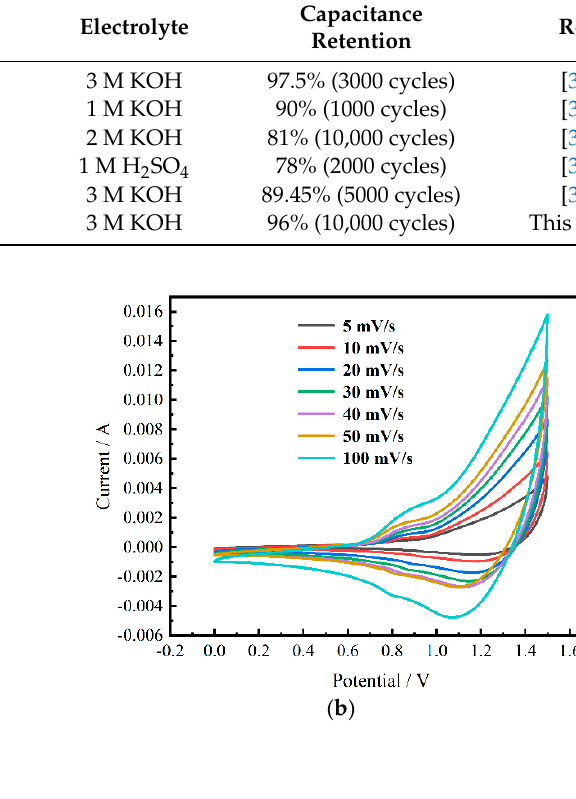
( f ) Figure 6. Electrochemical testing of NiMoO 4 @MnCo 2 O 4 composite assembled devices: ( a ) Cyclic voltammetry curves under different voltage windows; ( b ) Cyclic voltammetry curves of different scanning speeds; ( c ) GCD curves with different current densities; ( d ) Impedance diagram (inset is the high-frequency region); ( e ) Cycling stability and coulombic efficiency; ( f ) Ragone plots. 4. Conclusions A new type of NiMoO 4 @MnCo 2 O 4 composite electrode material has been successfully prepared on nickel foam by the two-step hydrothermal method, and its phase structures, micromorphology and electrochemical properties are characterized and analyzed. Due to the synergistic effect between the NiMoO 4 nano pompon-like structure and MnCo 2 O 4 nano needle-like structure, the prepared nano urchin-like NiMoO 4 @MnCo 2 O 4 core–shell nanostructure presents good pseudocapacitance properties. NiMoO 4 @MnCo 2 O 4 samples show better electrochemical performance than single NiMoO 4 or MnCo 2 O 4 electrode ma- terials, which exhibit a high specific capacitance of 3000 mF/cm 2 . After 10,000 cycles, the